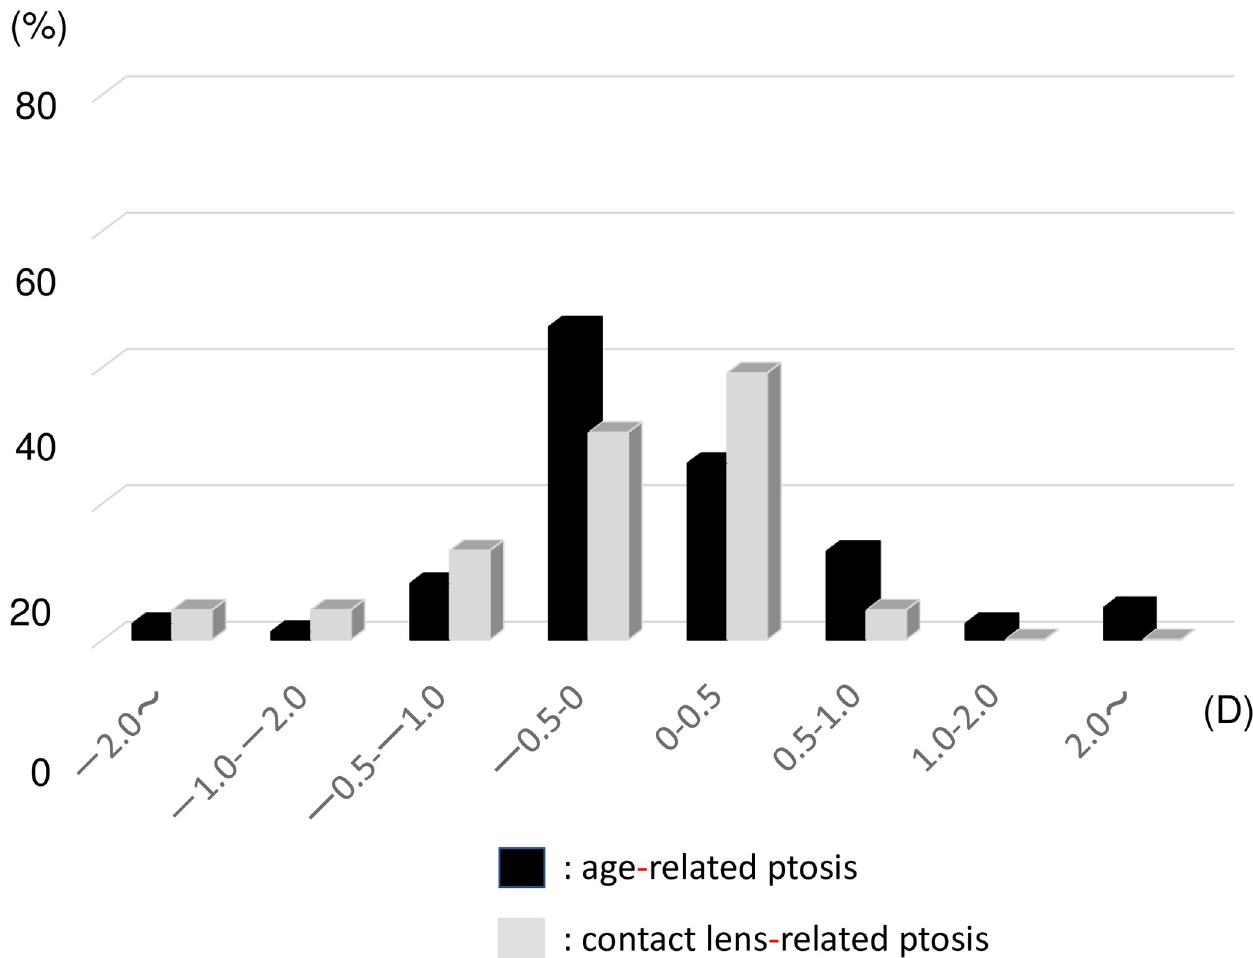
Fig 2. Distribution of blepharoptosis surgery-induced astigmatism as measured using the Cravy method in the age-related ptosis group (black bar) and the contact lens-related ptosis groups (gray bar). D: Diopter.